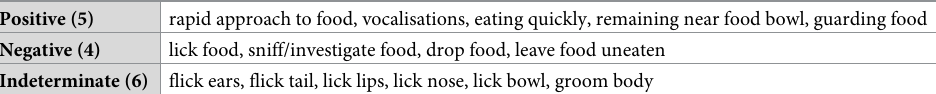
Table 4. Behavioural indicators of positive, negative or indeterminate palatability in 1,135 sampled cats. Positive (5) rapid approach to food, vocalisations, eating quickly, remaining near food bowl, guarding food Negative (4) lick food, sniff/investigate food, drop food, leave food uneaten Indeterminate (6) flick ears, flick tail, lick lips, lick nose, lick bowl, groom body